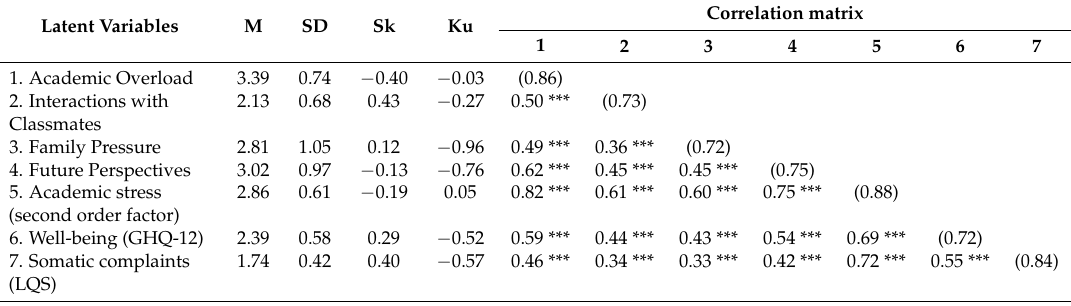
Table 4. Means (M), Standard Deviations (SD), Skewness (Sk), Kurtosis (Ku), Correlation matrix and Internal consistency (Cronbach’s alphas on the diagonal) of latent variables.